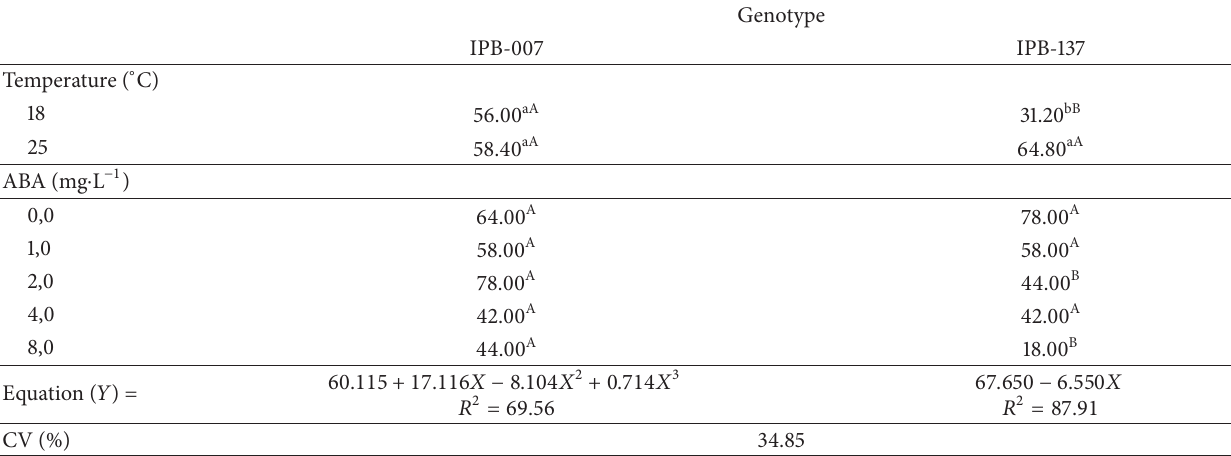
Table 1: Survival of sweet potato plant shoots after 180 days of in vitro conservation as a function of abscisic acid concentration, temperature, and genotype.